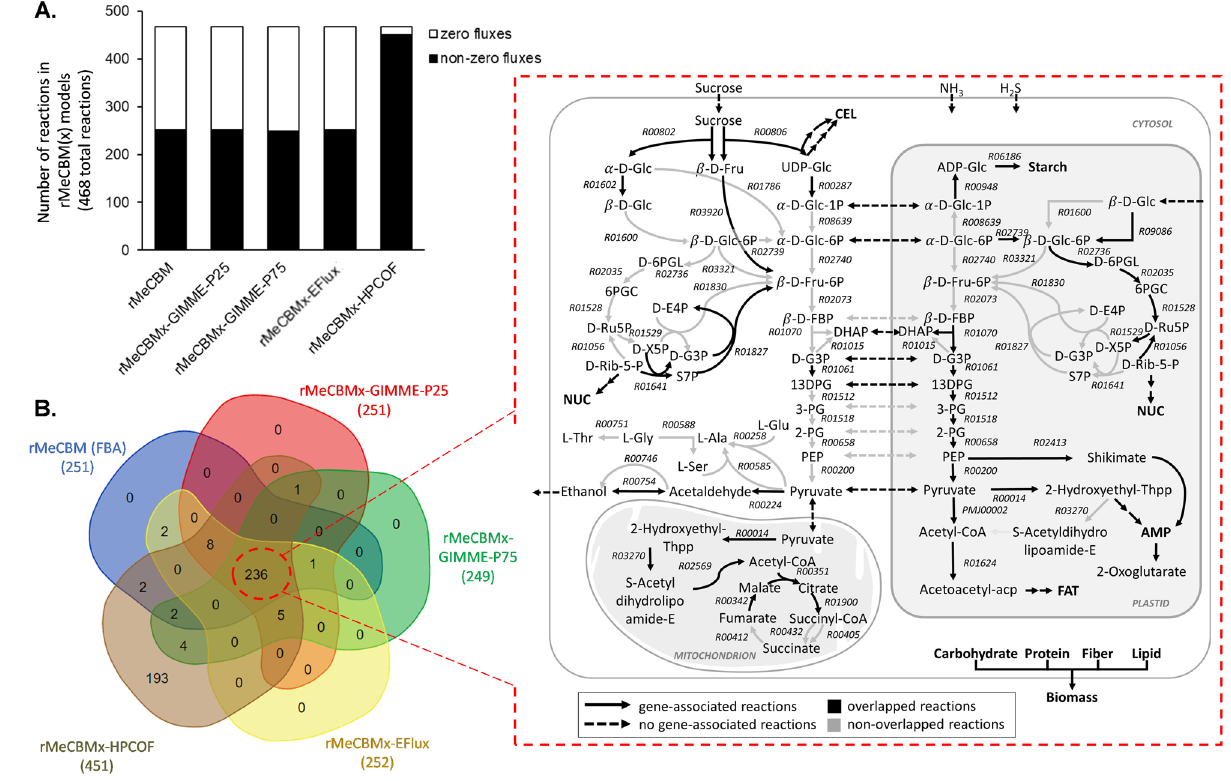
Figure 3. Simulation of the transcriptome-integrated CBM models (rMeCBMx) constructed using GIMME, E-Flux and HPCOF algorithms, ( A ) the number of non-zero (active) and zero (inactive) flux reactions from rMeCBM, rMeCBMx-GIMME-P25, rMeCBMx-GIMME-P75, rMeCBMx-EFlux, and rMeCBMx-HPCOF and ( B ) commonly predicted active reactions from all models, 236 of 468 total reactions denoted in the overlapped region of the Venn diagram and depicted in the schematic pathway as black solid arrows, postulated to be core metabolic reactions basically driving carbon assimilation in developing storage roots of cassava. Gray arrows denote trivial reactions obtained from some model predictions. The solid and dotted arrows represent genes associated with the